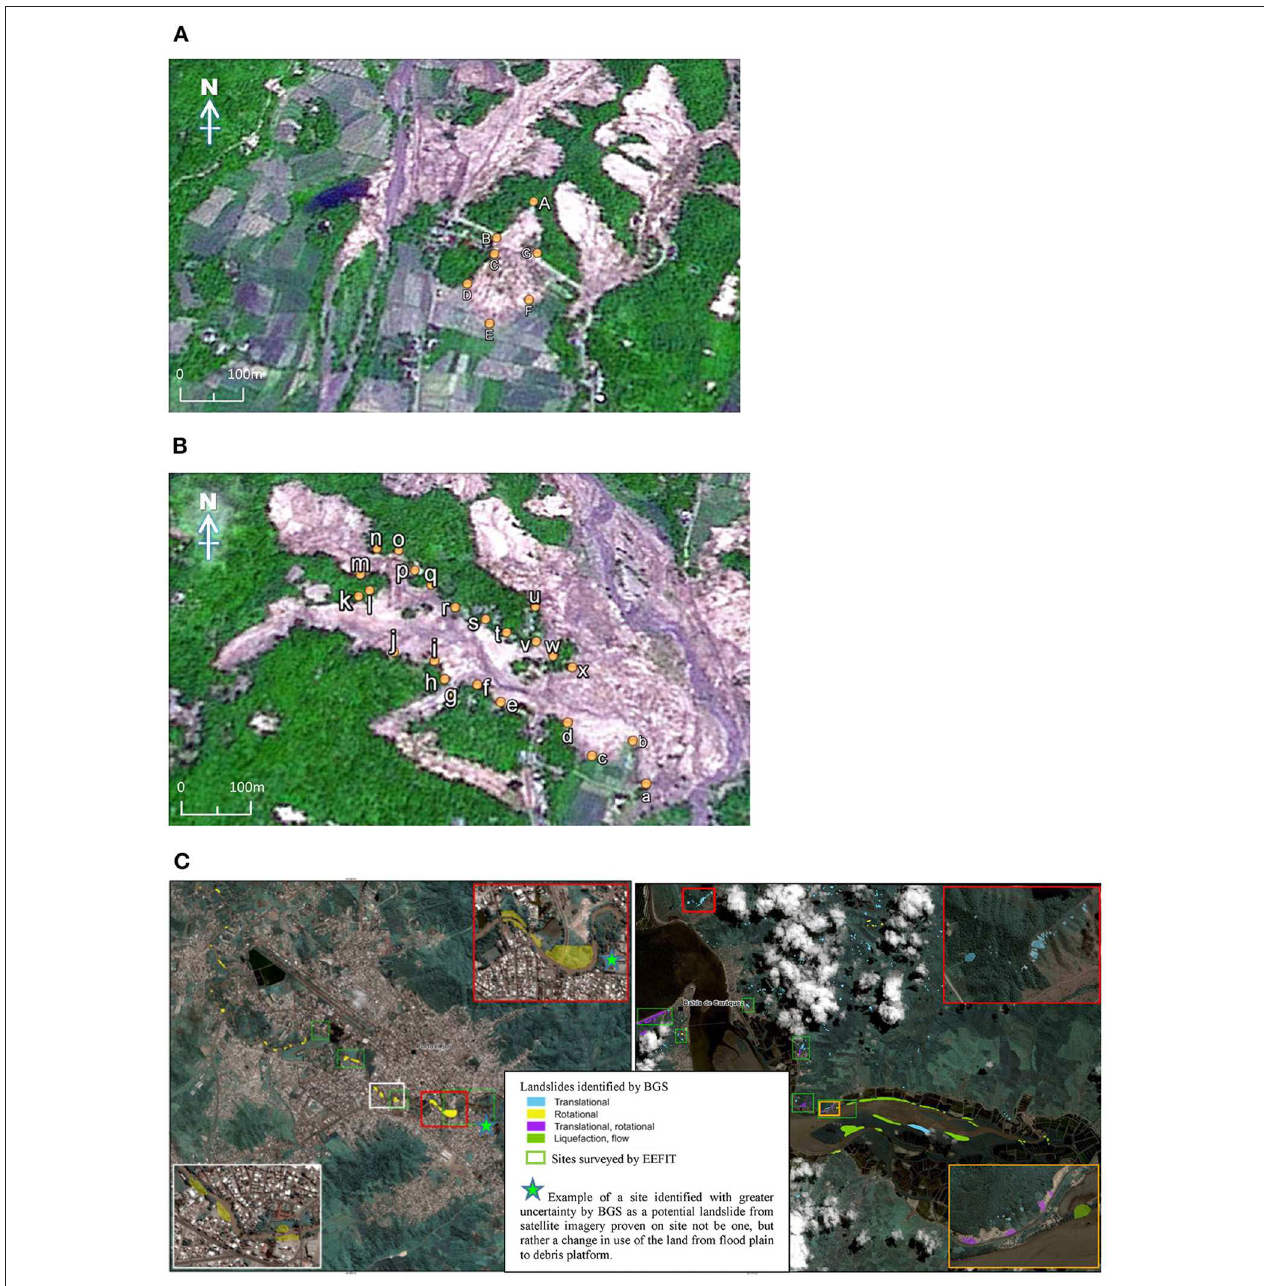
FIGURE 15 | Landslides in Sumatra and Ecuador identified from satellite imagery. (A) Locations of Landslide I boundary points at Pariaman, superimposed on SPOT-5 satellite image, acquired by Center for Remote Imaging, Sensing and Processing, National University of Singapore. (B) Locations of Landslide II boundary points at Pariaman, superimposed on SPOT-5 satellite image, acquired by Center for Remote Imaging, Sensing and Processing, National University of Singapore. (C) Landslide in Ecuador identified from satellite imagery, left: Portoviejo; right: Bahia de Caraquez (British Geological Survey, 2016a,b).